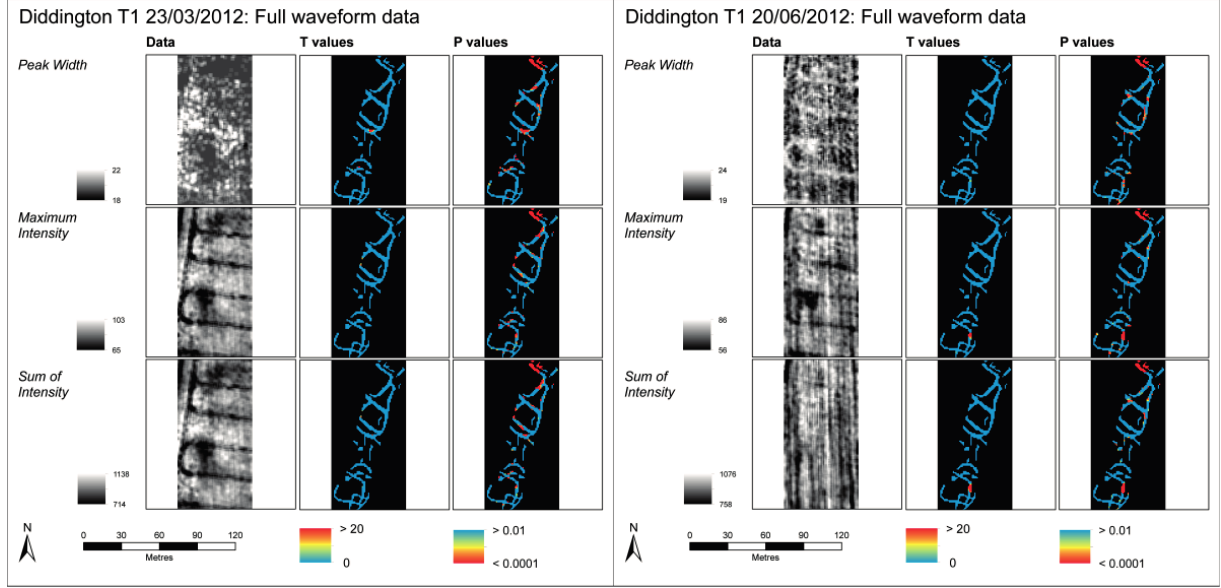
Figure 10. Metrics from airborne LiDAR full waveform data for Diddington T1 Field and corresponding T -values and P -values indicating localised